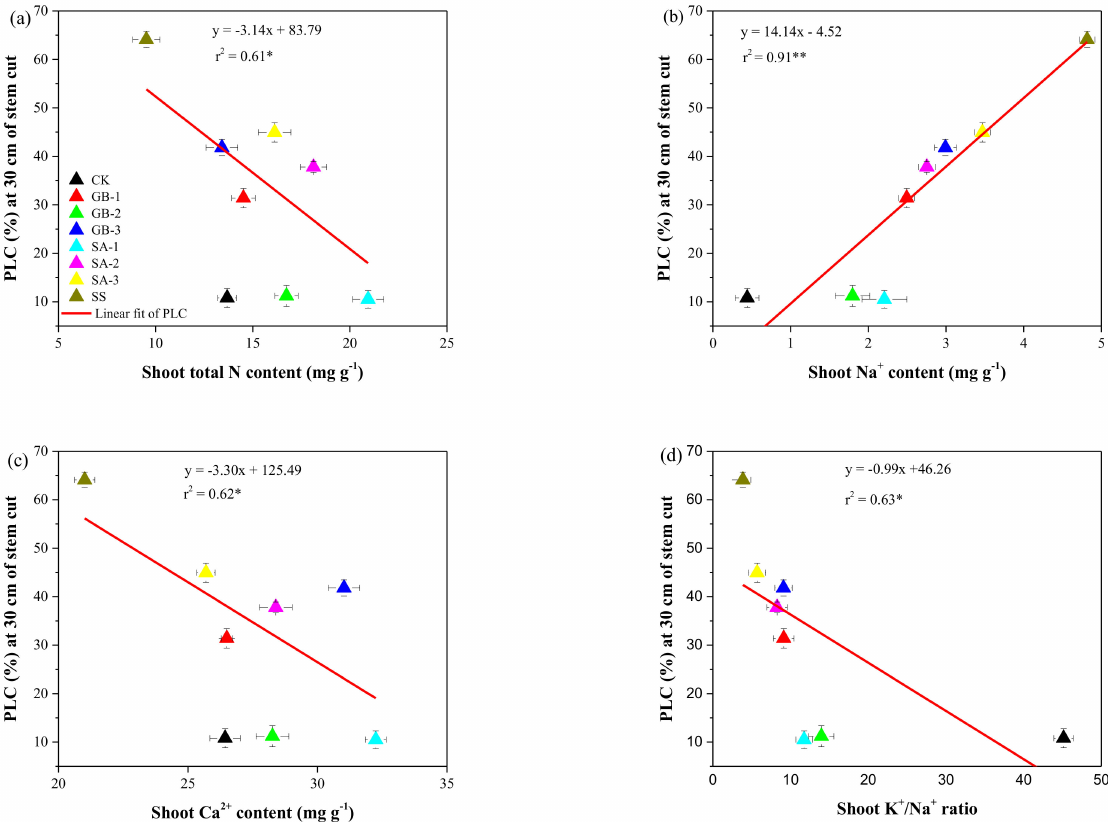
Figure 6. Relationship between ( a ) percentage loss of conductivity (PLC) and shoot total nitrogen (N) content, ( b ) PLC and shoot Na + content, ( c ) PLC and shoot Ca2+ content, and ( d ) PLC and K + /Na + ratio. Treatments: CK, control; GB2.5, 2.5 mM GB; GB5.0, 5.0 mM GB; GB7.5, 7.5 mM GB; SA1.0, 1.0 mM SA; SA1.5, 1.5 mM SA; SA2.0, 2.0 mM SA; SS, salt stress (150 mM) without supplementation. Values are means (n = 3), and error bars represent standard deviations; * and ** show significance levels at p < 0.05 and p < 0.01,